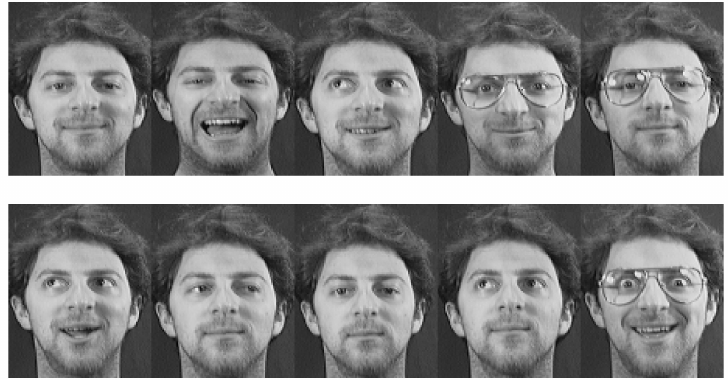
Figure 5. Face image of an individual in ORL face